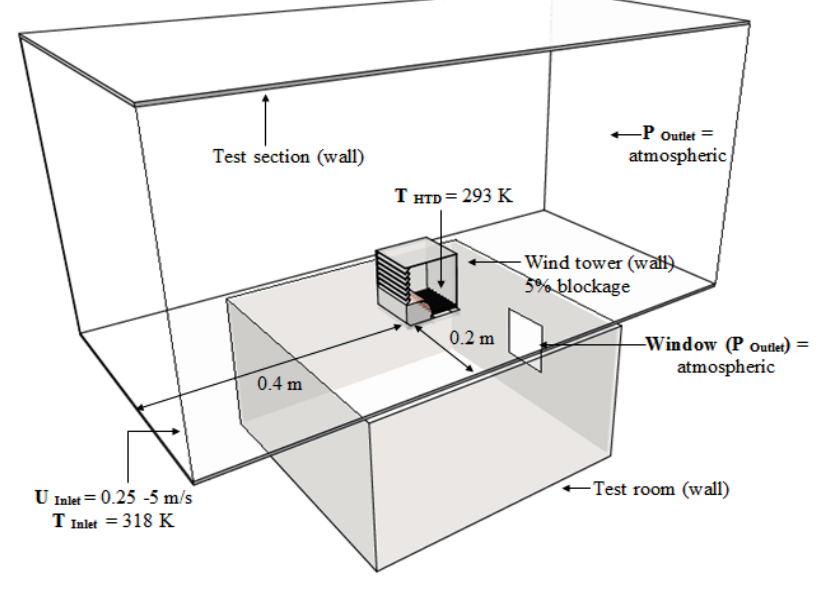
Figure 7. Flow domain of the computational model showing the boundary